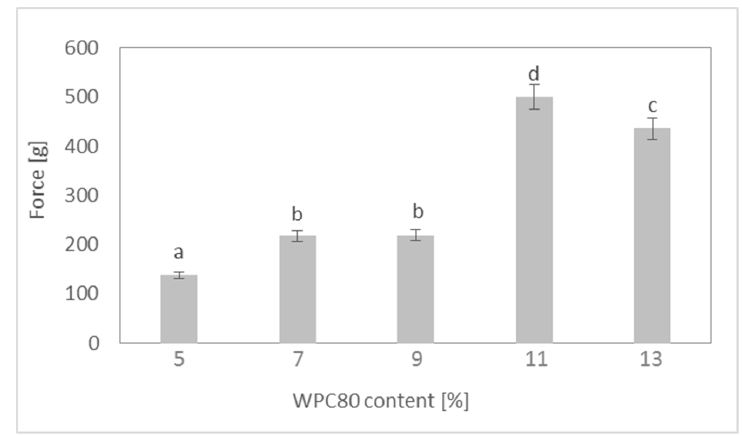
Figure 2. Effect of different WPC80 contents on force values of high-protein fat-free dairy desserts. Letters (a–d) indicate significant differences at p < 0.05 (Tukey’s HSD